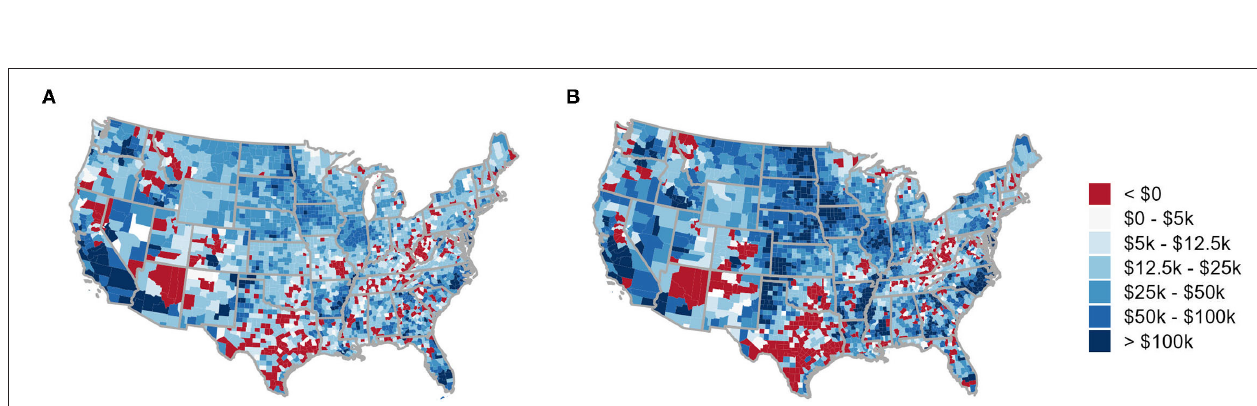
Frontiers in Sustainable Food Systems |